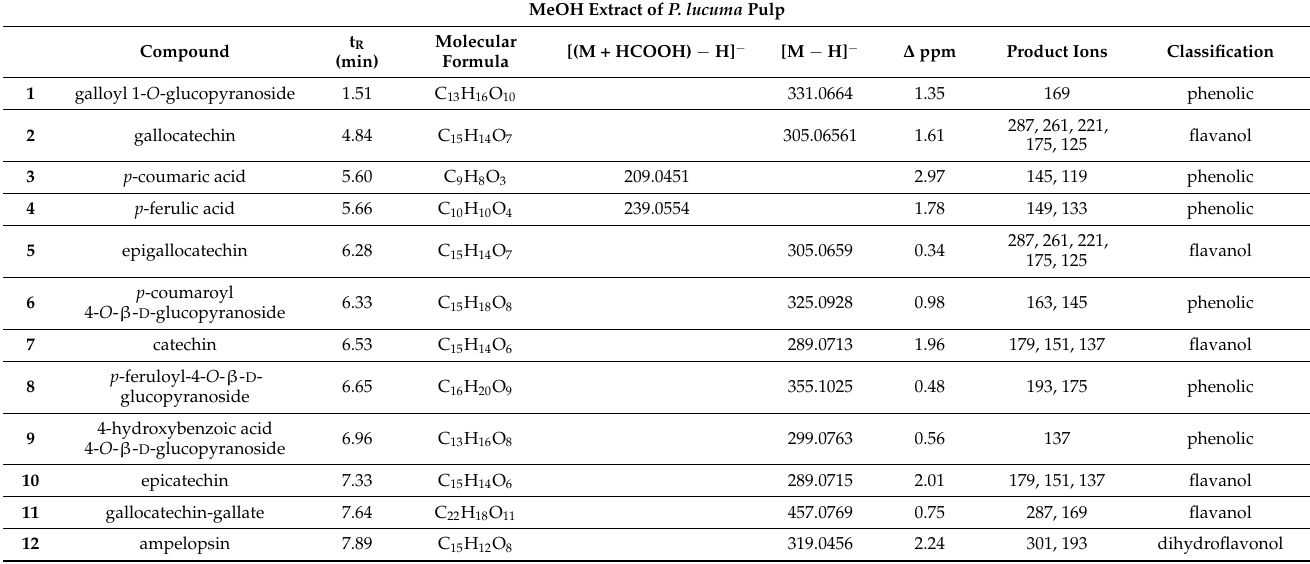
Table 2. Compounds identified in P. lucuma pulp n -BuOH extract and P. lucuma skin MeOH extract by LCESI/ LTQOrbitrap/MS/MS (negative ion